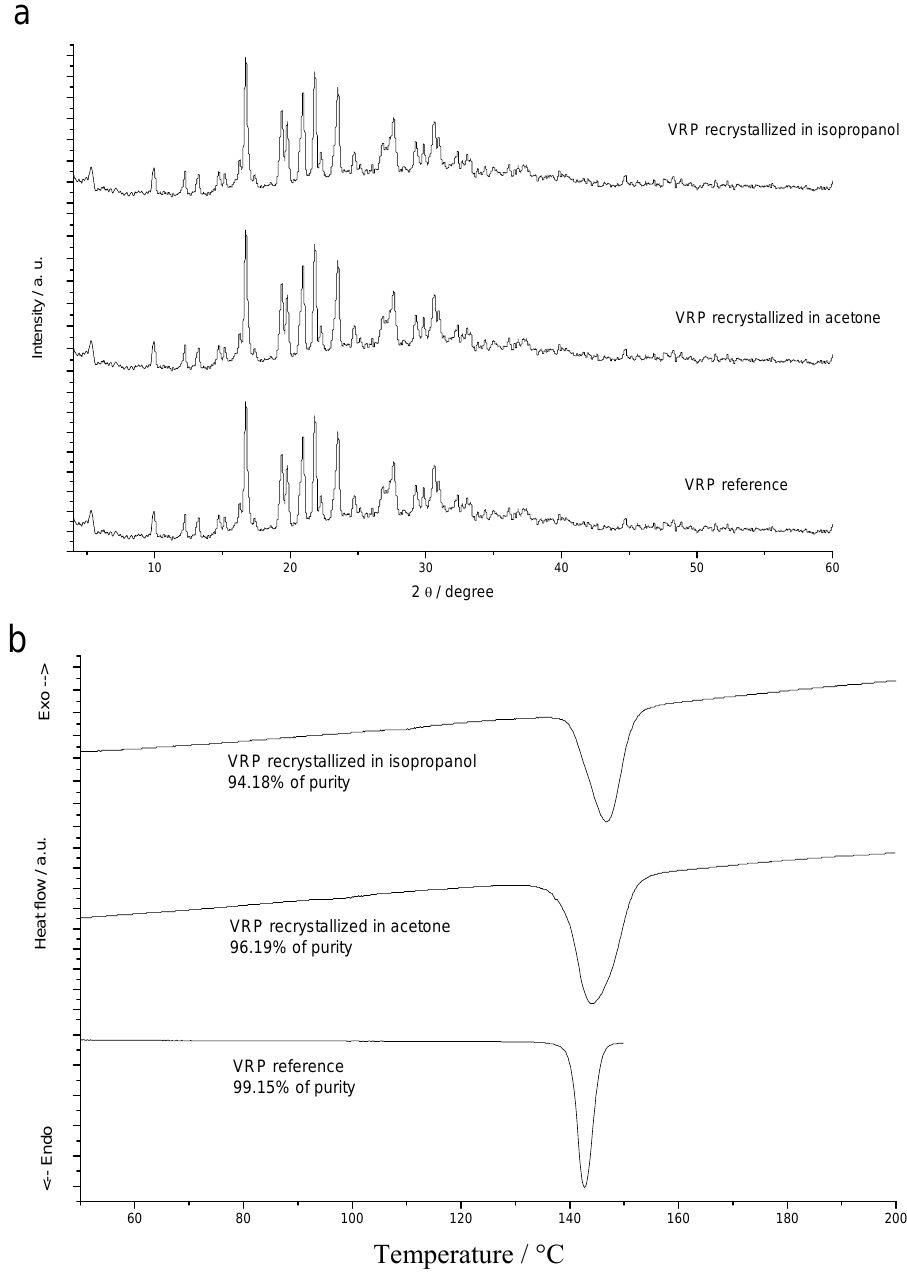
Figure 5. (a) XRD and (b) DSC results obtained for verapamil hydrochloride (VRP): reference, recrystallized in acetone and in